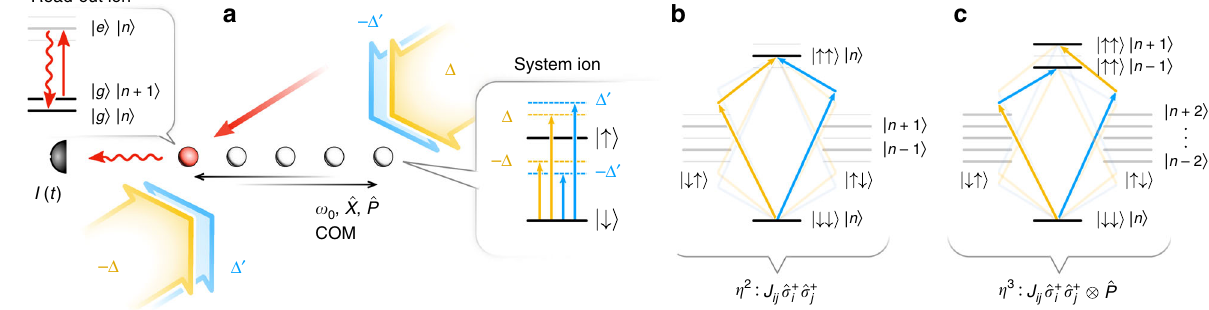
Fig. 2 Trapped-ion implementation of the system-meter Hamiltonian ^ H double Mølmer – Sørensen con fi guration. As described in the text this generates ^ H the meter variable ^ P representing the COM motion. The meter variable ^ X is read by driving one, or potentially several ancilla ions (red) with a laser (red beam) tuned to the red motional COM sideband (see text). Homodyne detection of the scattered light to read ^ X , and thus revealing ^ H in the photocurrent I ð t Þ (cid:6) h ^ H i [see Eq. (5)]. b Level scheme of a pair of ions sharing the COM phonon mode, illustrating one of the elementary processes contributing to the P c ^ σ x ^ σ x J I in second order in η . c Level scheme showing the corresponding third-order processes contributing to (cid:2) ϑ Ising term (cid:2) ij i j (cid:3) i < j (see Fig. 2) is detuned by ± Δ from ionic resonance, while the second pair (blue) is detuned by ± Δ 0 . Furthermore, we choose Δ 0 (cid:2) Δ ¼ ω with ω 0 the COM frequency. These four laser beams give rise to 0